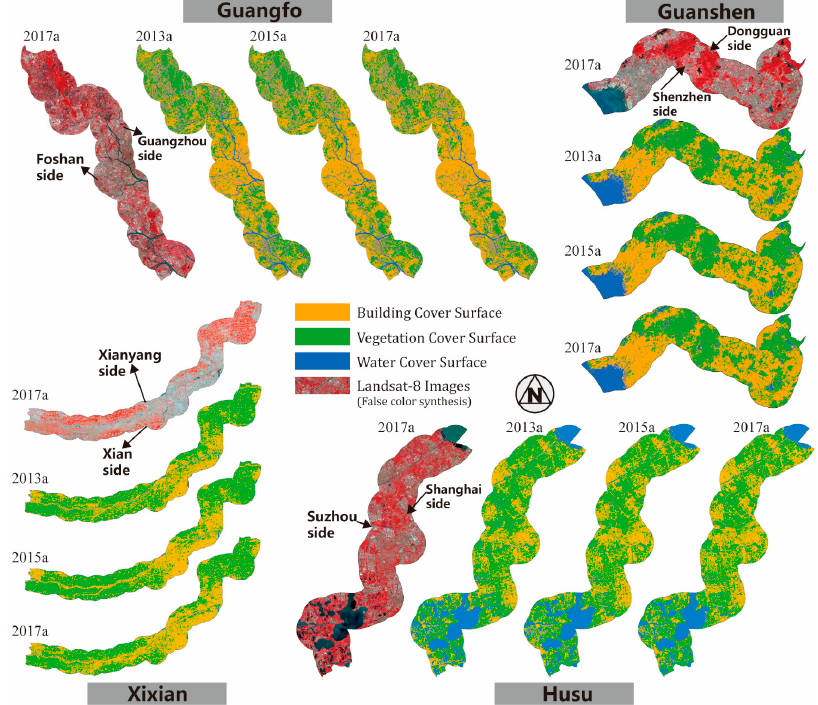
Figure 2. The land-use classification results of boundary zones among the integrated cities in 2013, 2015, and 2017.